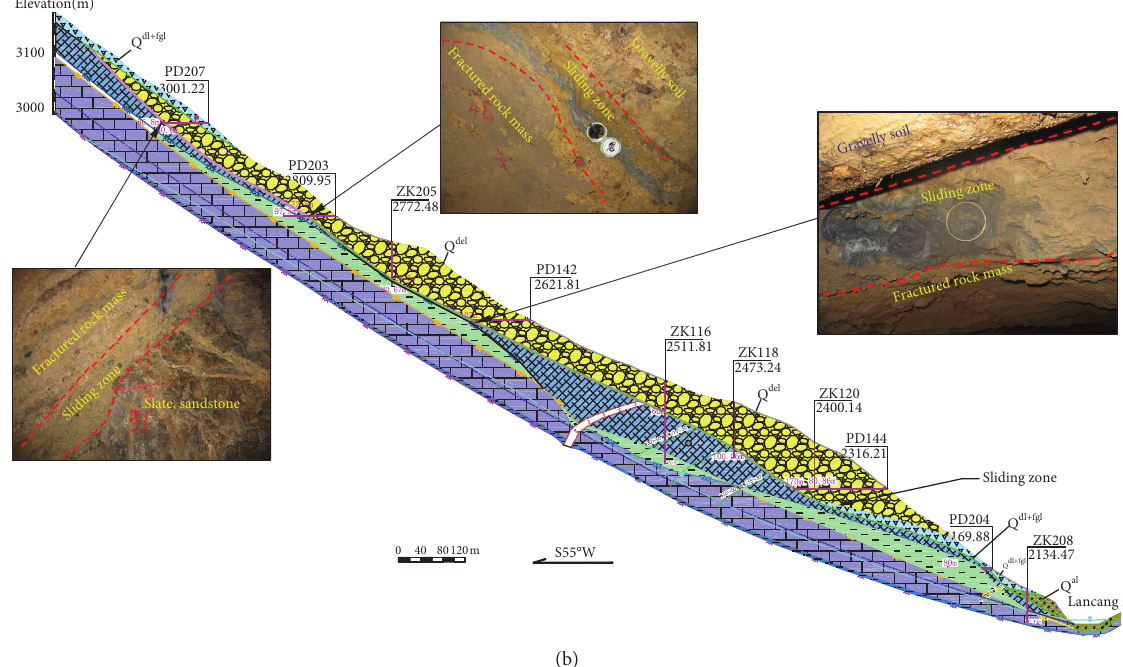
Figure 5: Characteristics of the sliding zone in the drill holes and exploratory adits. (a) Profile A-A’ in zone I. (b) Profile B-B’ in zone II.